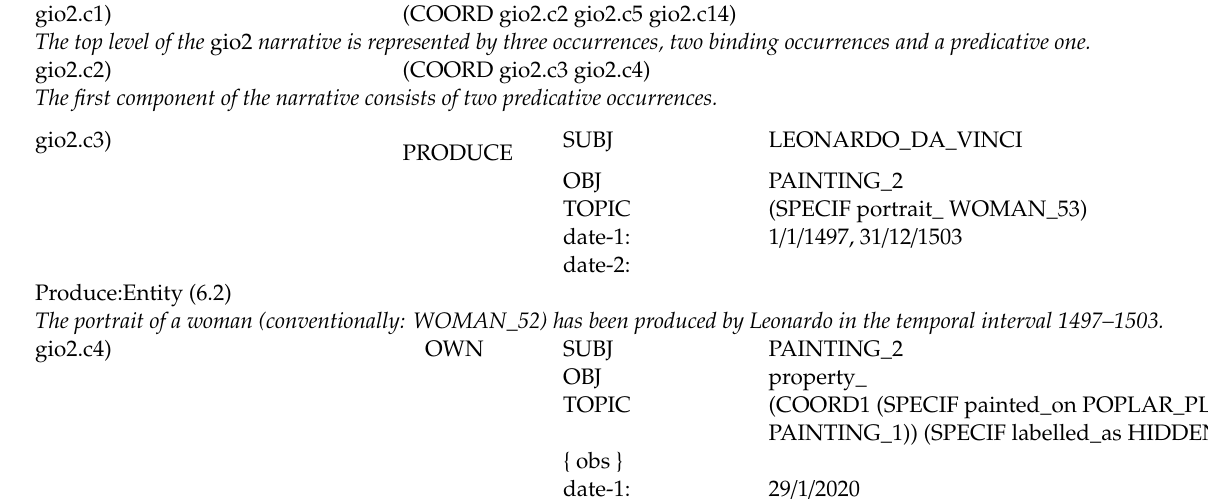
Table 3. Formalization of the Isabella d’Aragona